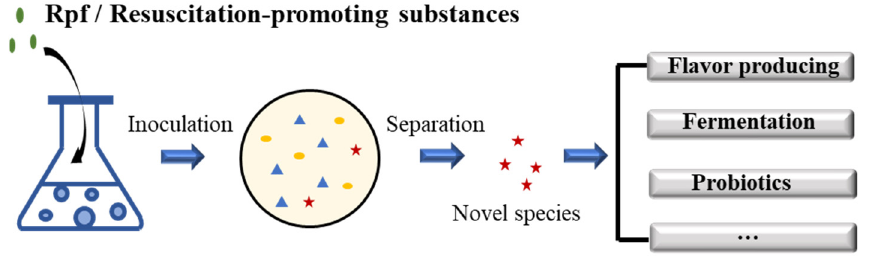
Figure 5. Assumption of VBNC bacteria resuscitation to separate novel species for application in the food industry.